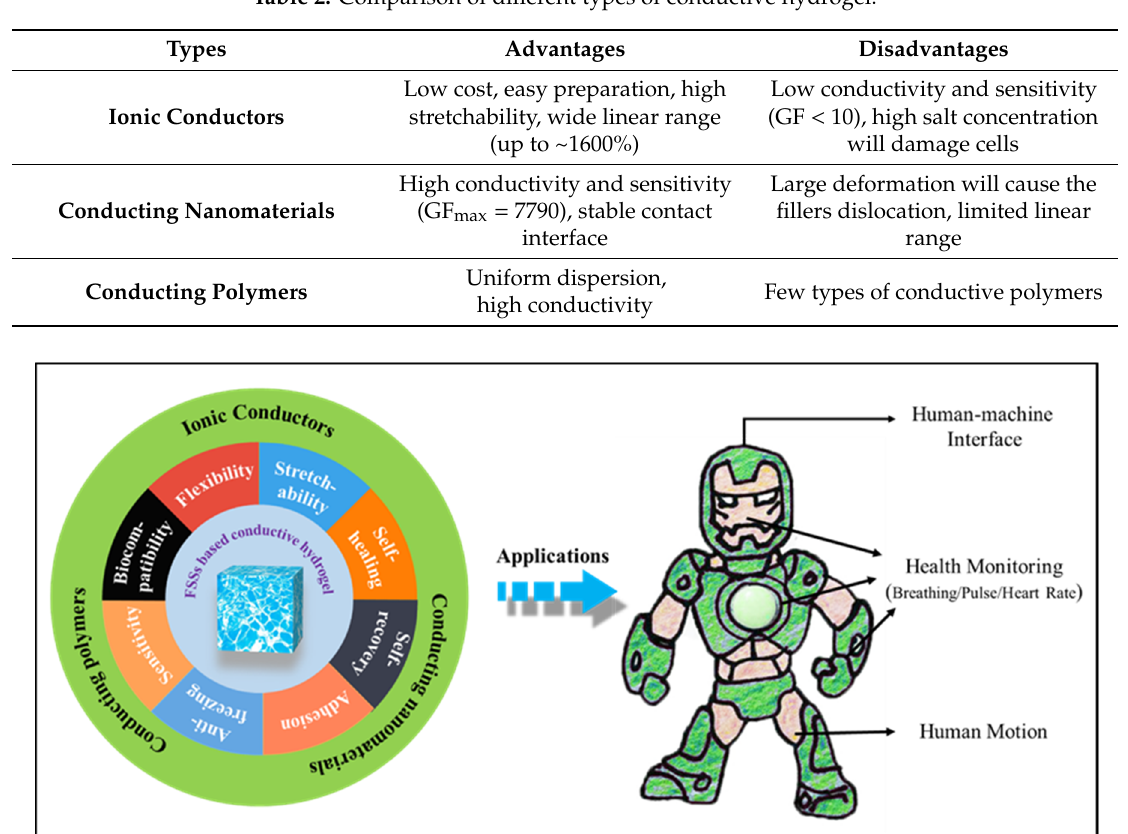
Figure 9. The properties and applications of FSSs based on conductive hydrogel.